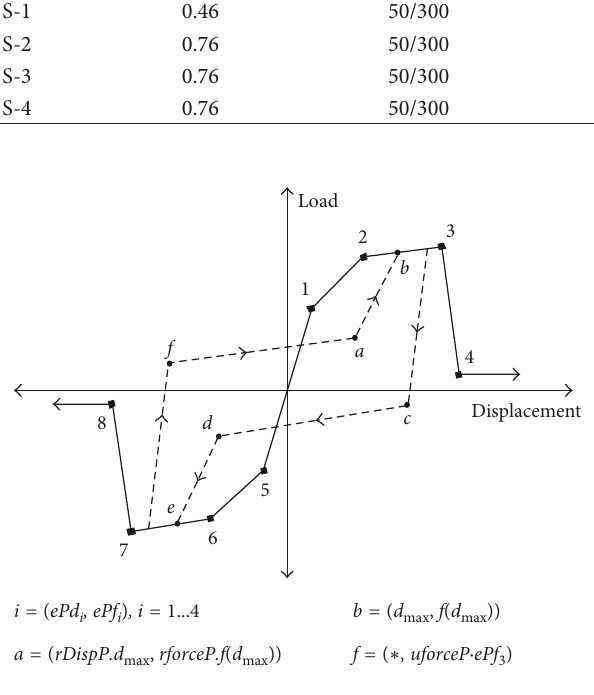
Figure 2: Hysteresis model for Pinching 04 material.